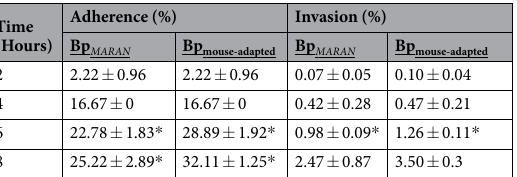
Table 1. Mean percentage of Burkholderia pseudomallei MARAN and mouse-adapted adherence and invasion. Foot note: * p-value ≤ 0.05.